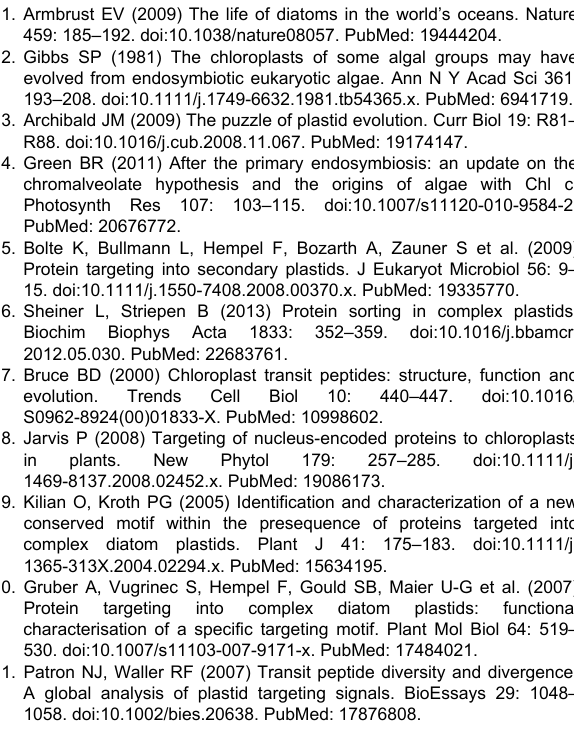
Table S5. List of 1295 unique N terminal peptides from 939 nuclear-encoded T. pseudonana proteins. A non-redundant list of unique N terminal peptides, identified by database searches with Mascot and X! Tandem, was generated using an in-house script (see methods section for details). JGI ID, JGI protein model accession number; peptide, peptide sequence; position, peptide start position as matched to protein sequence; spectra (dimethylated), number of spectra identifying the N- terminally dimethylated form of this peptide; spectra (acetylated), number of spectra identifying the N-terminally acetylated form of this peptide.